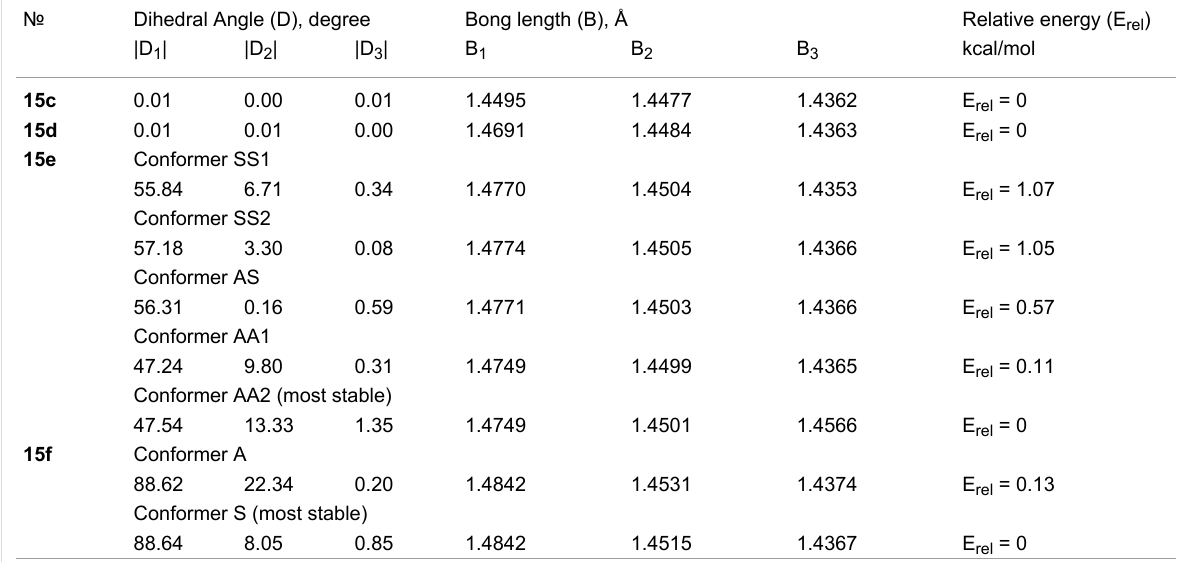
Table 3: Selected geometrical parameters (bond lengths, B and dihedral angles, D) for all found conformers of the studied compounds a , as well as relative energies, E rel , for each conformer in the ground state obtained for DCM solution (IEFPCM) at the B3LYP/Def2-SVPD level of theory. № Dihedral Angle (D), degree Bong length (B), Å